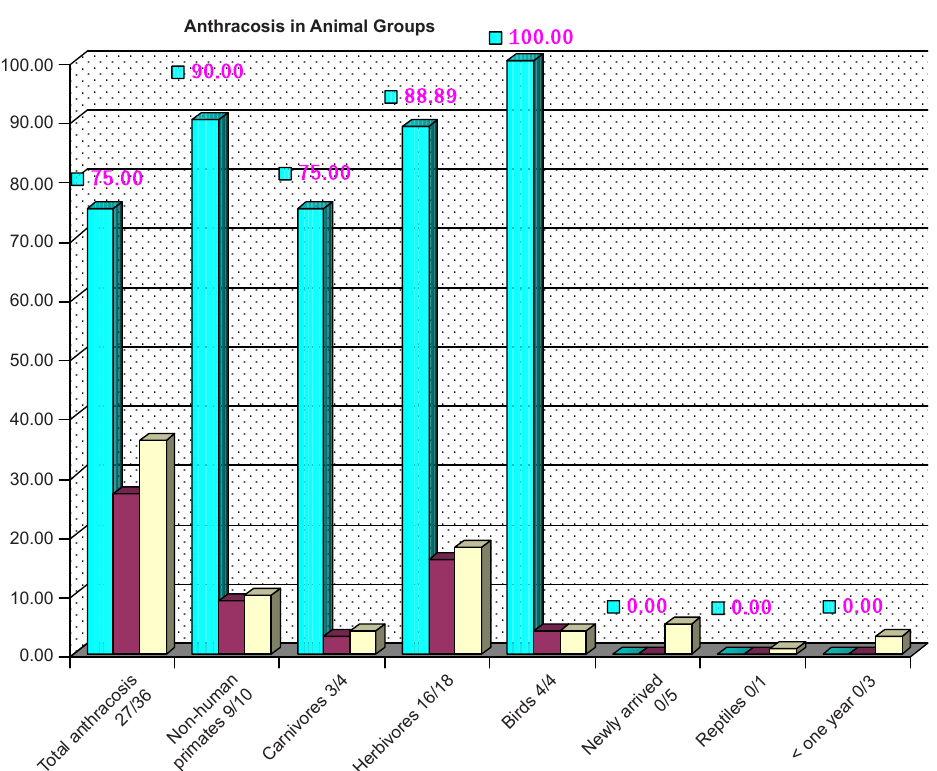
a l T o t Figure 1. Percentages of Anthracosis